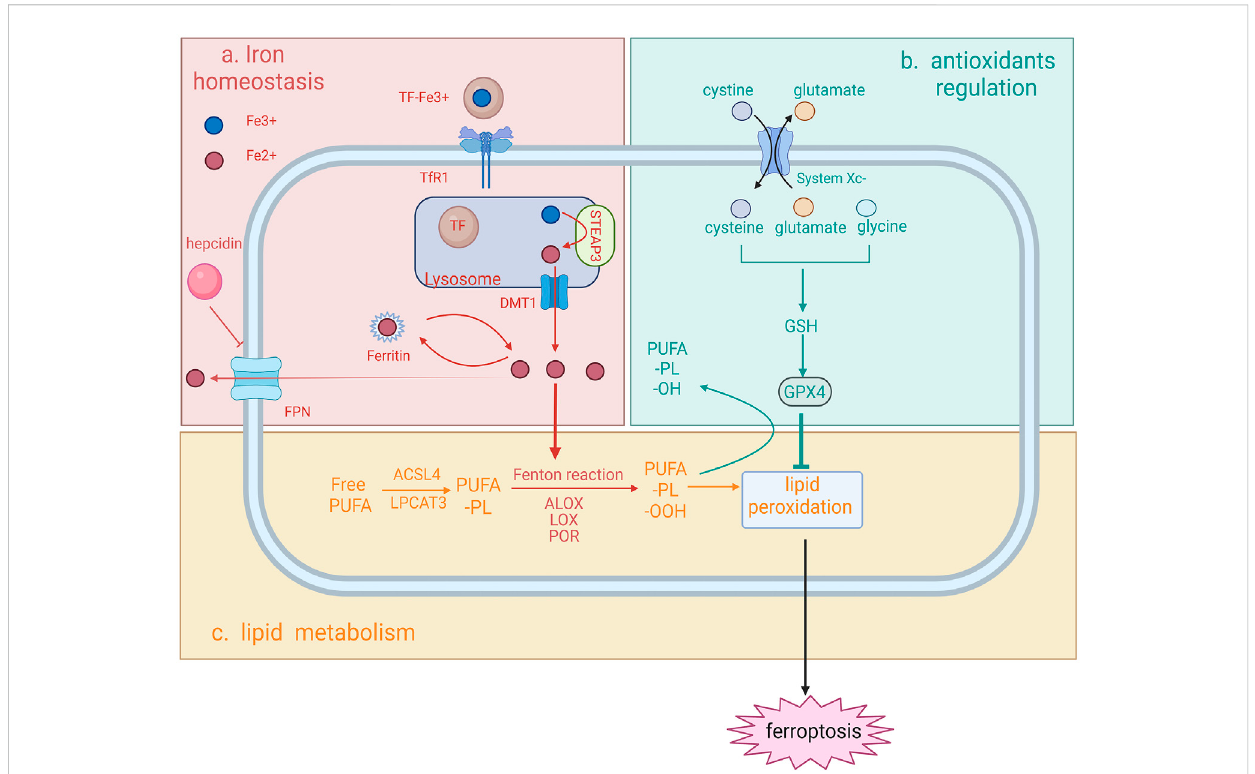
FIGURE 1 Schematic representation of the molecular mechanism of ferroptosis ferroptosis can be characterized by the intersection of iron homeostasis (A) , antioxidantsregulation (B) andlipidmetabolism (C) . (A) Ironhomeostasis(topleft).Ironis fi rstinternalizedintheformofTF-Fe 3+ via TfR1andthiscomplex dissociates once entering the lysosome. Fe 3+ is reduced into Fe 2+ by STEAP3 and further transported outside the lysosome. In the cytosol, Fe 2+ is either stored in the form of DMT1 or exported by FPN. FPN can be inhibited by hepcidin, thus regulating cytosolic iron availability. In the process of ferroptosis,theimpairedironimport,storageorexportcontributestotheironoverloadandconsequentlypromotesiron-dependentFentonreactionand the action of iron-dependent enzymes and thereby lipid peroxidation. (B) Antioxidants depletion (top right). GPX4, a key antioxidant in ferroptosis, is responsible for the reduction of toxic lipids and its depletion leads to the failure of the suppression of lipid peroxidation. (C) Lipid metabolism (at the bottom). For lipid peroxidation to occur, free PUFA needs to be incorporated into phospholipid to form membrane-bounded PUFA-PL. The following Fenton reaction mediated by an excessive iron together with insuf fi cient antioxidant activity contributes to the overproduction of PUFA-PL-OOH and fi nally ferroptotic cell death (created with